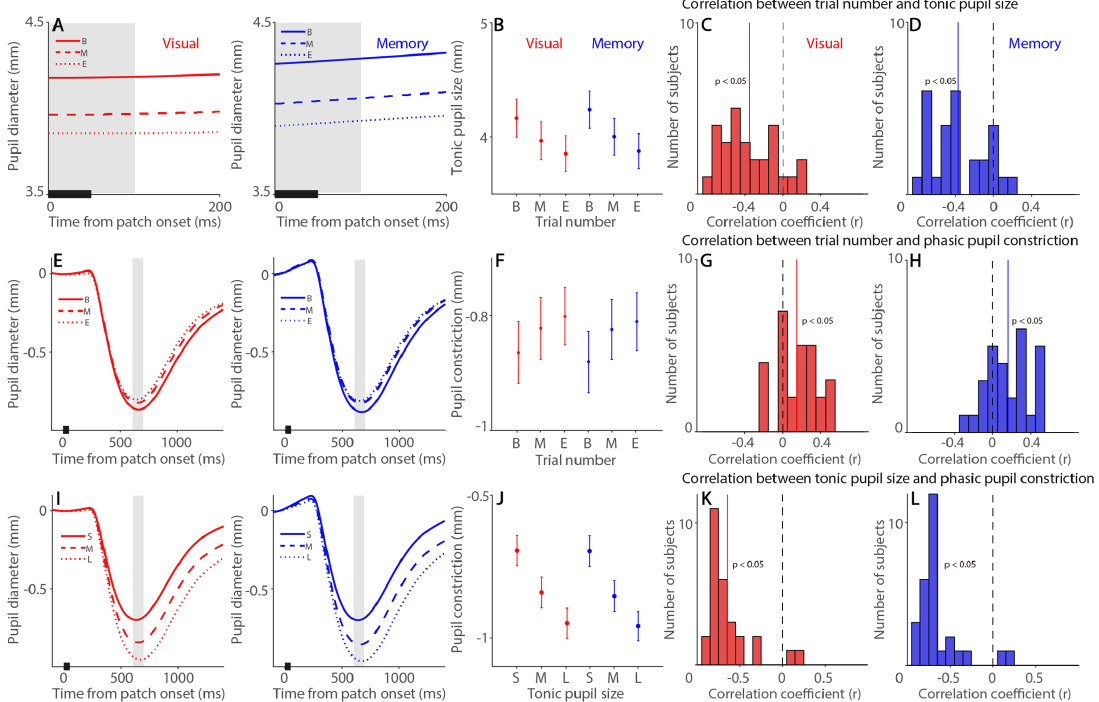
Figure 3. Time-on-task effects on tonic pupil size and phasic pupil constriction. ( A ) Dynamics of absolute pupil diameter following the presentation of bright patch stimuli. ( B ) Tonic pupil size (0 to 100 ms after patch onset) in different trial number conditions in the visually guided and memory-guided saccade task. ( C , D ) Distribution of correlation coefficients for the relationship between trial number and tonic pupil size in the visually guided ( C ) and memory-guided ( D ) saccade task for all subjects ( n = 28). ( E ) Changes in pupil diameter following the presentation of bright patch stimuli. ( F ) Pupil constriction size (600 to 700 ms after patch onset) in different trial number conditions on the visually guided and memory-guided saccade task. ( G , H ) Distribution of correlation coefficients for the relationship between trial number and phasic pupil constriction size in the visually guided ( G ) and memory-guided ( H ) saccade task for all subjects. ( I ) Changes in pupil diameter following the presentation of bright patch stimuli. ( J ) Pupil constriction size (600 to 700 ms after patch onset) in different tonic pupil size conditions in the visually guided and memory-guided saccade task. ( K , L ) Distribution of correlation coefficients for the relationship between tonic pupil size and phasic pupil constriction size in the visually guided ( K ) and memory-guided ( L ) saccade task for all subjects. In ( A , E , I ), the black bar on X-axis indicates the time line of patch presentation. The analyzed epochs are shaded in gray. In ( B , F , J ), the error bars represent ± standard error range (across participants). In ( C , D , G , H , K , L ), the vertical black dashed line represents a zero value of the correlation coefficient (r = 0), and the vertical colored line represents the mean value of the correlation coefficient. Visual: visually guided saccade task. Memory: memory-guided saccade task. B: begin, M: mid, E: end. S: small, L: